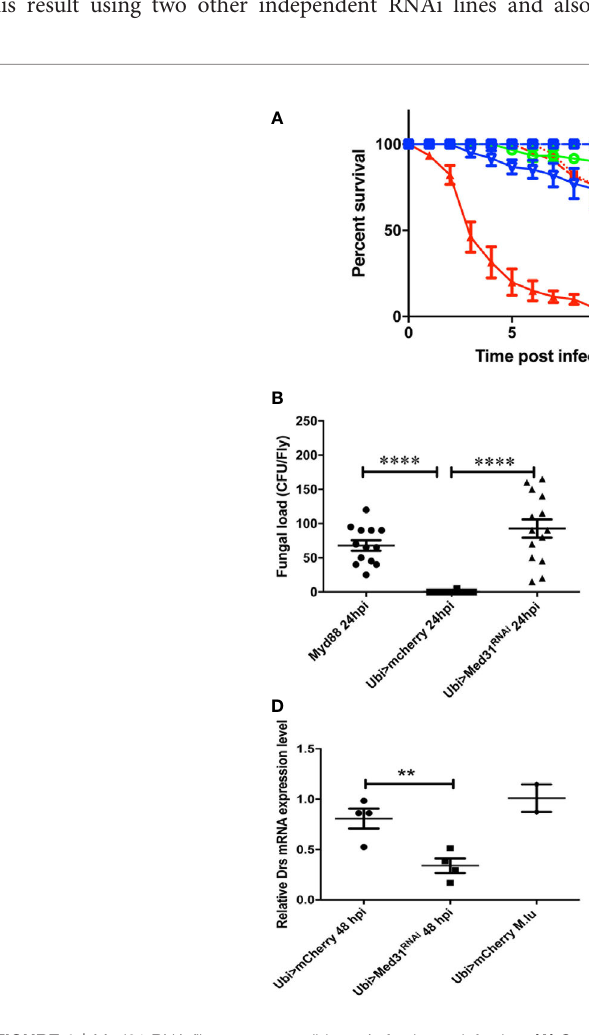
FIGURE 1 | Med31 RNA fl ies are susceptible to A. fumigatus infection. (A) Survival of Drosophila after A. fumigatus infection. MyD88 is the positive control line (red), Ubi> mCherry RNAi line is the wild type control line (green) and Ubi> Med31 RNAi line is the experimental line (blue). Each infected line has a non-infected (NI, dashed lines) and PBS-injected control (dotted lines). Med31 RNAi fl ies succumbed faster to infection than the wild type controls. Infected Med31 RNAi fl ies vs . infected mCherry RNAi fl ies: log-rank test, ****P < 0.0001. The survival curves are representative of 10 independent experiments. (B, C) Fungal load of whole single fl ies after 24 and 48 h of infection. Each dot represents a single fl y. The fungal load was higher in MyD88 and Med31 RNAi fl ies than in control fl ies at 24 h post infection. It did not increase in Med31 RNAi fl ies at 48 h post infection compared to 24 h. ****P < 0.0001. ***P < 0.001. (D, E) Expression levels of Drosomycin (D) and DIM1 (E) at 48 h post infection, normalized to Rpl32 (RP49 protein coding gene) housekeeping gene expression. The expression of control fl ies challenged with the nonpathogenic Gram-positive bacterium Micrococcus luteus is given for reference. Each dot represents one sample containing four fl ies. Med31 RNAi fl ies displayed decreased Drosomycin and DIM1 expression levels at 48 h post infection. *P < 0.05. Mean ± SEM are indicated (B – E)